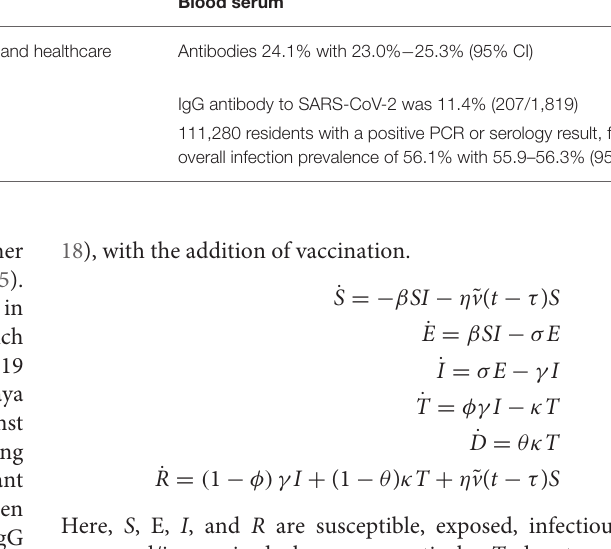
TABLE 1 | Coronavirus disease 2019 (COVID-19) serum survey conducted in three places. Time